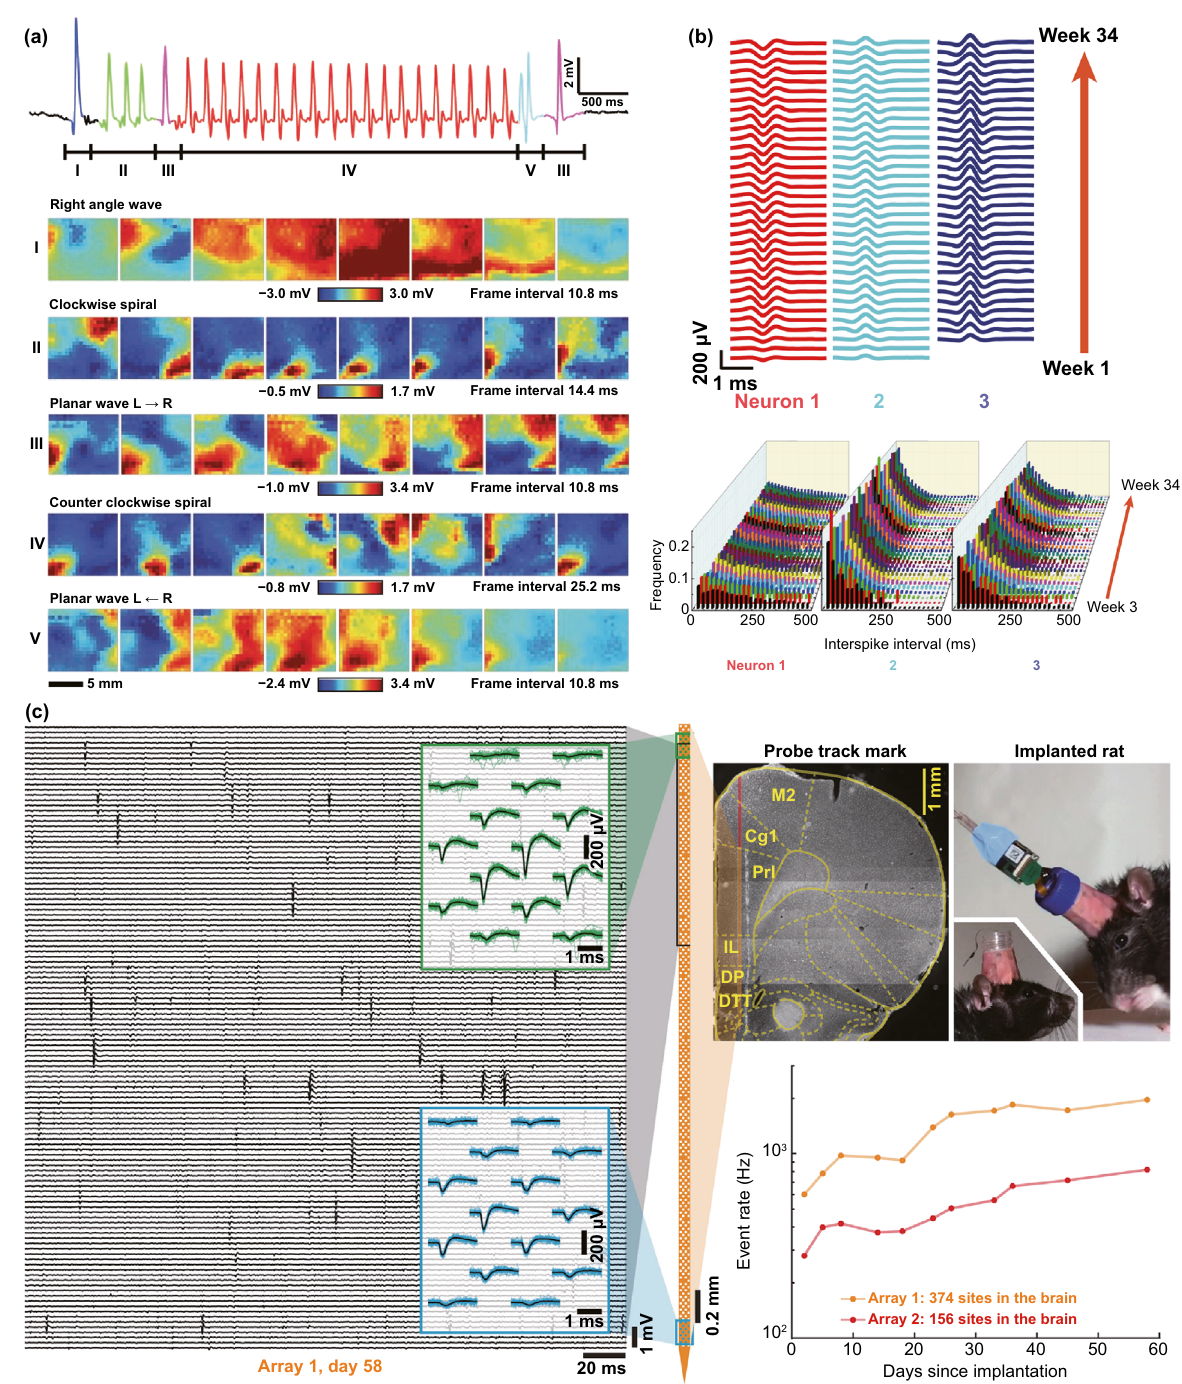
Fig. 18 High‑throughput and long‑term neuroscience study by semi‑implantable devices. a High‑throughput µECoG signal recording by 360 transistor‑based arrays during a short seizure. Transistor array can visually display the high spatiotemporal resolution movie frames in vari‑ ous patterns [305]. b Long‑term chronic single‑neuron recording by neuron‑like semi‑implantable device for 34 weeks [306]. c 960 CMOS semi‑implantable device for high‑throughput and long‑term recording [303]. Reproduced with permission from Refs. [303, 305, 306],